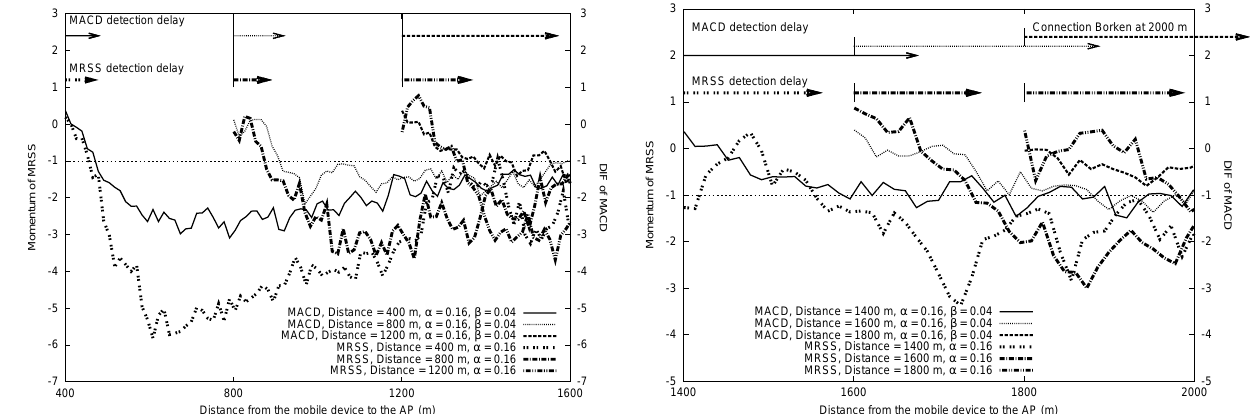
Figure 11. The effect of leaving movement in the Mobile WiMAX environment.